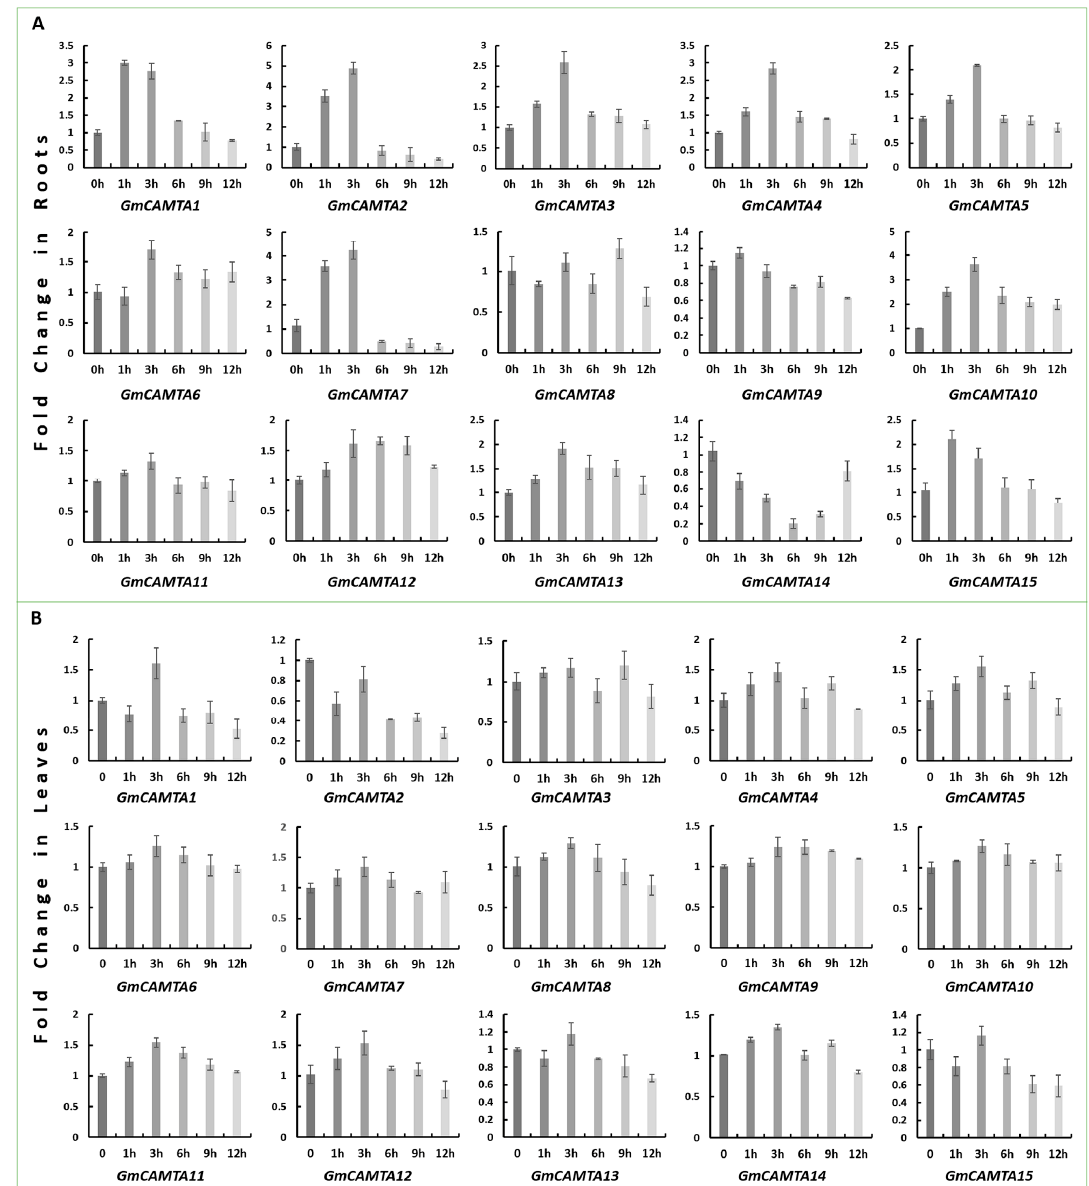
Figure 4. Spatiotemporal expression analysis of GmCAMTA in drought. ( A ) Relative fold expression of GmCAMTAs in Roots. Soybean plants were treated with 6% PEG6000 in Hoagland’s solution for five different durations (1, 3, 6, 9 and 12 h) along with a control (0 h). ( B ) Relative fold expression of GmCAMTAs in Leaves.